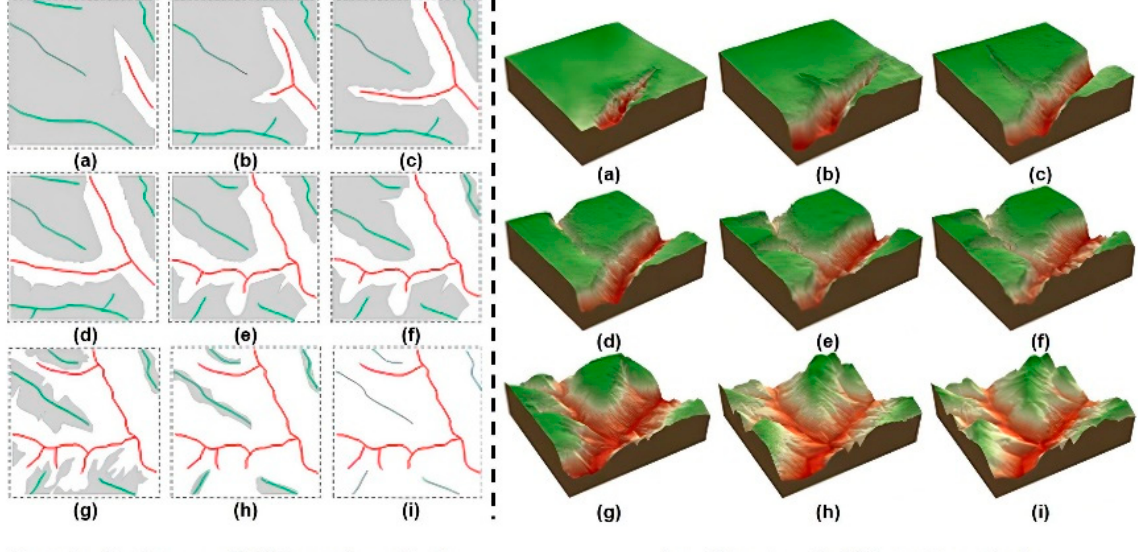
Figure 9. Simulating landform evolution based on different inputting terrain features. ( a – i ) represent terrain features ( left ) and landforms of different periods ( right ), respectively.